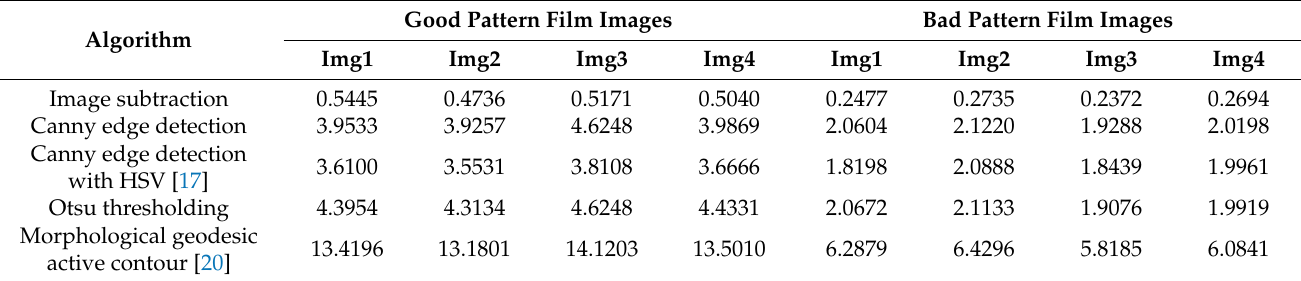
Figure 8. Good and bad 3D film images with comparison algorithms. Table 2. Results of Edge Projection Index for Good pattern film images and Bad pattern film images.